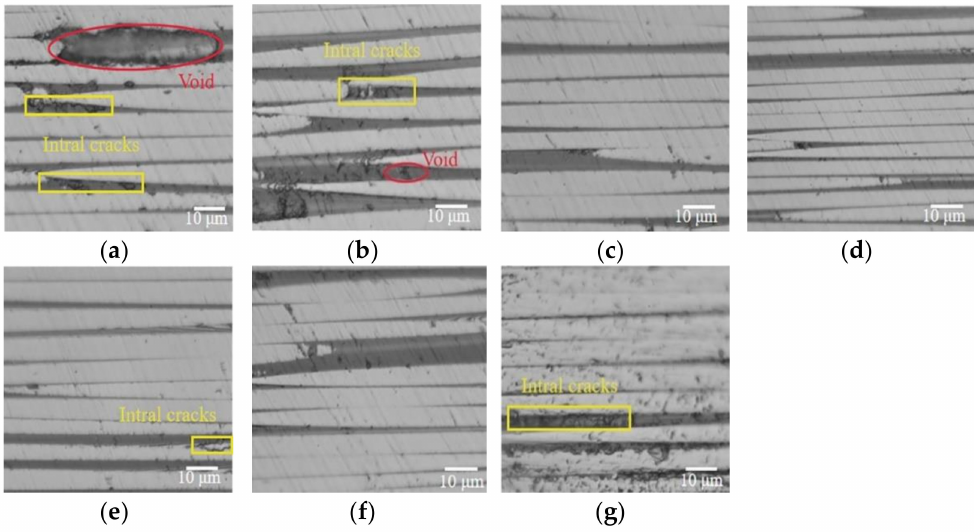
Figure 7. The cross-sectional optical digital micrographs of composite laminates, ( a ) 0.0 MPa auto- clave process, ( b ) 0.2 MPa autoclave process, ( c ) 0.4 MPa autoclave process, ( d ) 0.6 MPa autoclave process, ( e ) 5 g RVAVP, ( f ) 10 g RVAVP, ( g ) 15 g